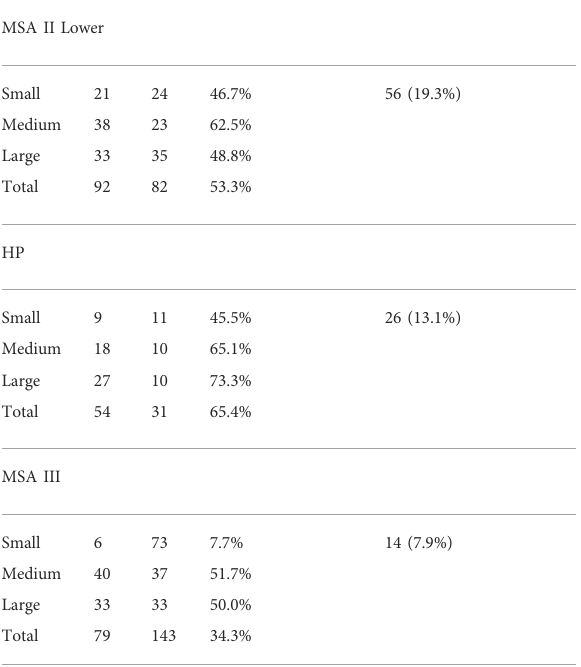
TABLE5Theproportionofpercussion(PM) versus toothmarks(TM)at Klasies River based on Thompson et al. 2017. Values above 50% indicate anthropogenically accumulated